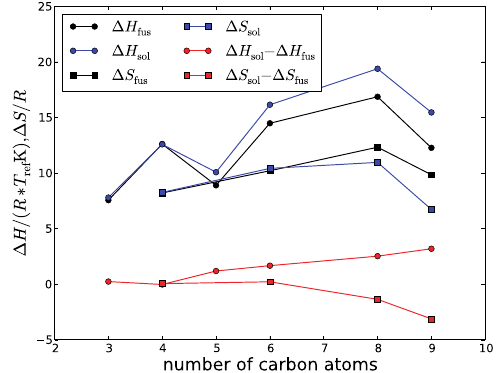
Fig. 3. Logarithm of the solubility mole fraction at 298.15K of lin- ear diacids, and of the ideal solubility mole fraction, as calculated by Eq. (13). Solubility data was taken from Apelblat and Manzurola (1987, 1989, 1990), and Bretti et al. (2006), fusion data from Booth et al. (2010); Roux et al. (2005).